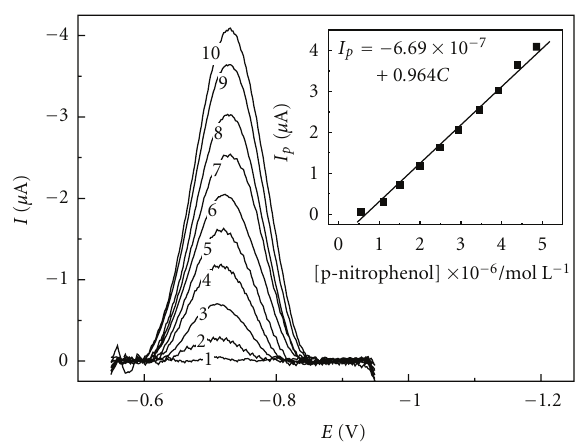
Figure 3: Square wave voltammograms obtained for the reduction of 4-NP for the AgSAE in 10mL of BR bu ff er (pH 7.0), f = 100s − 1 , a = 50 mV, and Δ E s = 2mV, with additions of 0.55 (1); 1.10 (2); 1.51 (3); 2.00 (4); 2.49 (5); 2.94 (6); 3.45 (7); 3.92 (8); 4.39 (9); 4.86 (10) × 10 − 6 moLL − 1 4-NP solutions.The insert shows the analytical curve